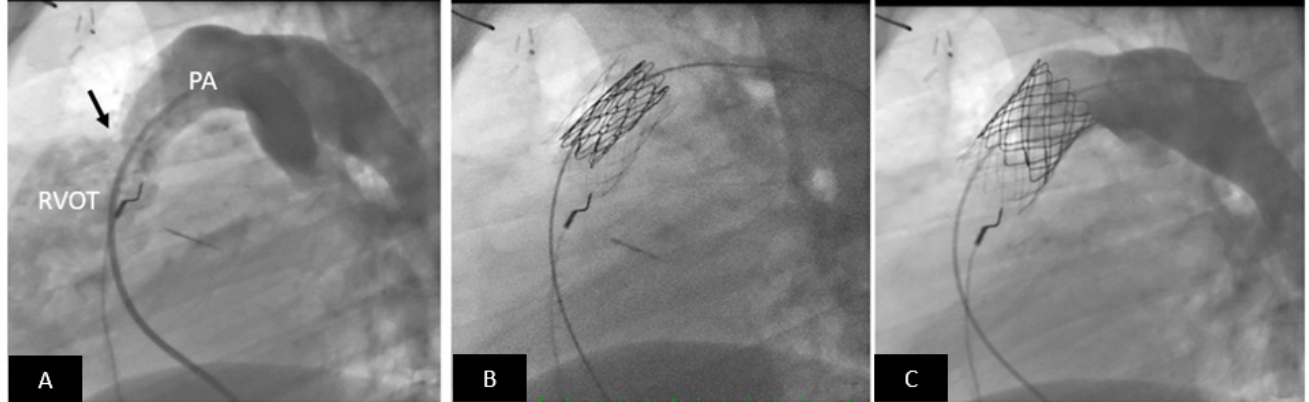
Figure 8. Transcatheter pulmonary valve replacement using a Medtronic Melody Valve. ( A ) Lateral angiogram showing a stenotic (arrow) RV-PA conduit; there is mild calcification. ( B ) The RV-PA conduit is prepared to receive the Melody valve by placement of a pre-stent (lighter stent frame). Also seen is the partially expanded Melody valve within the pre-stent (darker stent frame). ( C ) Excellent angiographic result with a well-positioned transcatheter Melody valve; note there is no pulmonary regurgitation. PA = pulmonary artery, RVOT = right ventricular outflow tract.